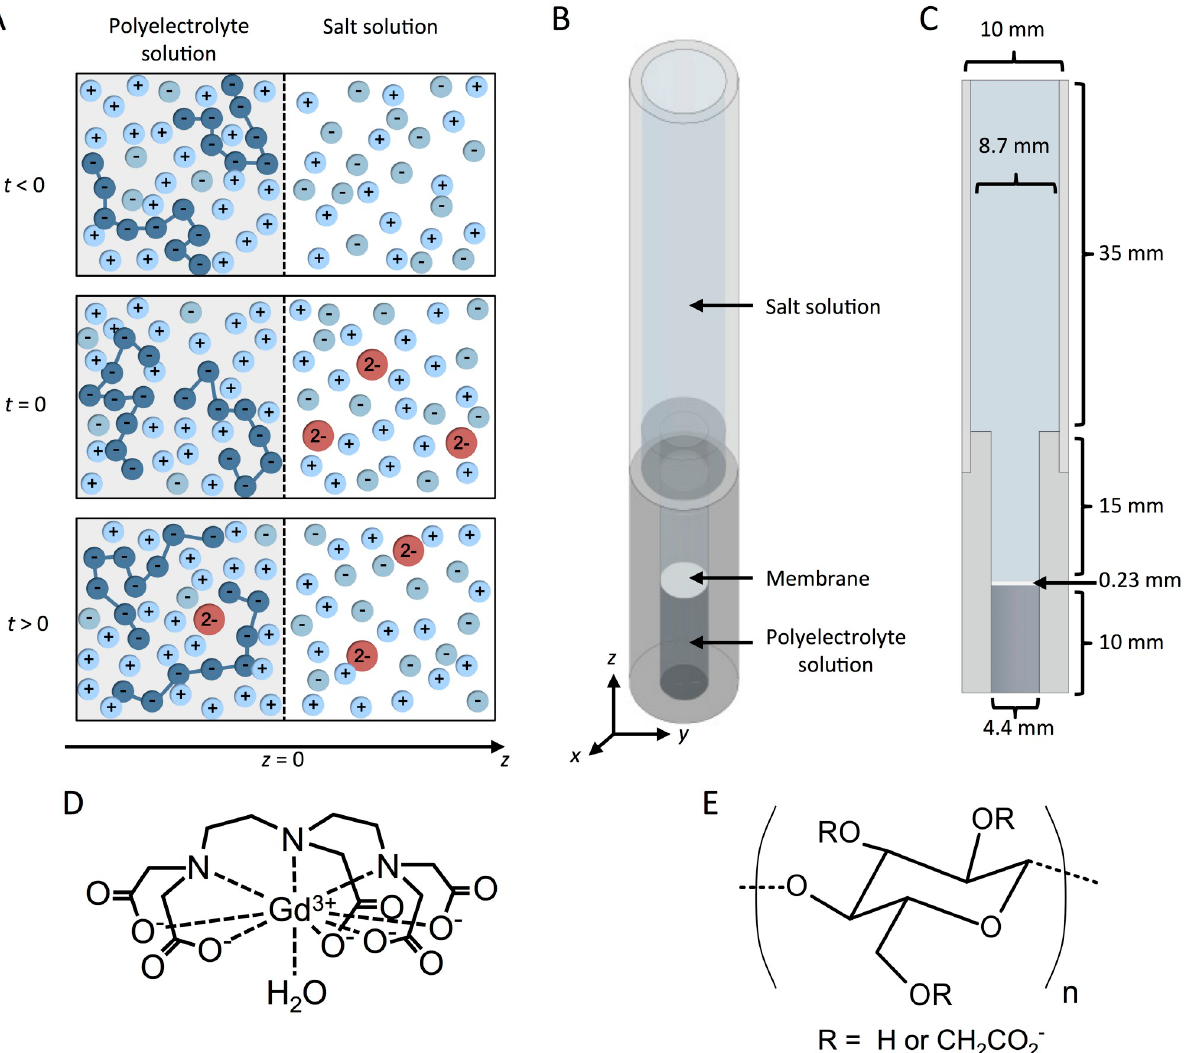
Fig 1. Presentation of the experimental and theoretical model systems. (A) The model system at different times. The polymer is negatively charged. At t < 0 there is thermodynamic equilibrium between the two solutions. At time t = 0, Gd(DTPA) 2 − is added to the salt solution and is allowed to flow over the semipermeable membrane into the polyelectrolyte solution. In the system c polyelectrolyte- and salt-solution, respectively). Moreover, because the polymer is negatively charged, the following will be true: c